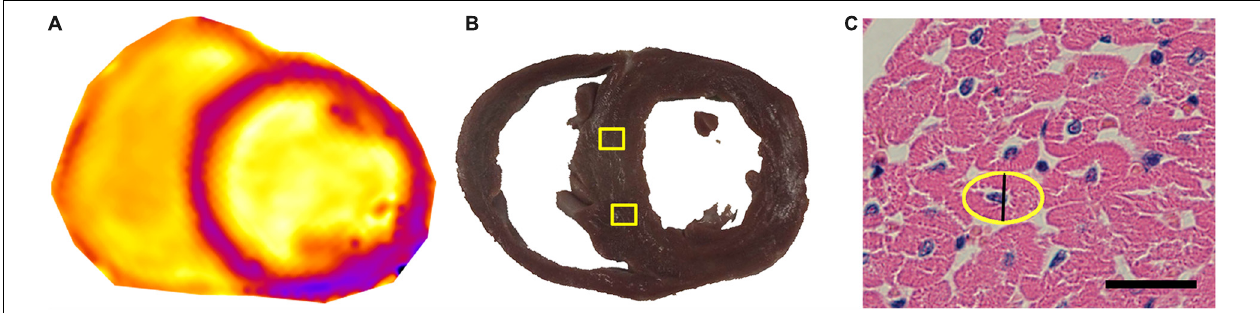
FIGURE 3 | Pathological ROIs corresponding to the T1 map, and CmyB measurement in H&E staining. (A) T1 map of the heart before enhancement. (B) The thickness of the gross pathological slice was 6 mm, and the yellow boxes indicate the ROIs of sampling areas corresponding to the T1 map. (C) Myocardial sections of H&E staining were observed at 400 × magnification, bar = 20 µ m; the yellow oval indicates the contour of the cross-section of the cardiomyocyte, and the black line shows the CmyB (10.2 µ m). ROI indicates region of interest; CmyB, cardiomyocyte breadth; H&E, hematoxylin and eosin.